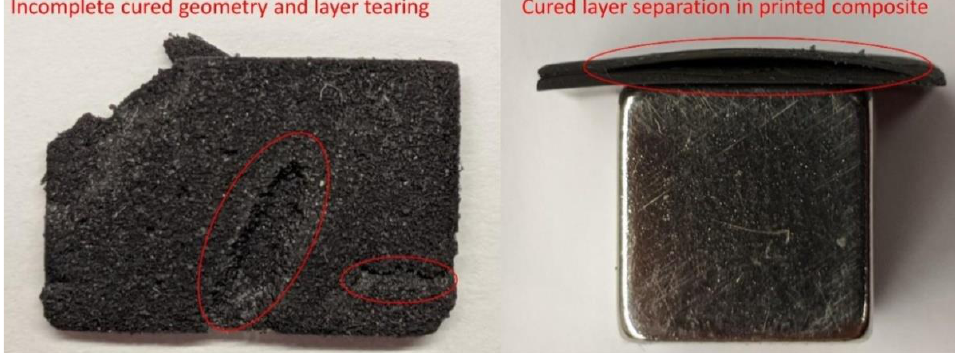
Figure 5. Defects in SrFeO ( left ) and NdFeB composite ( right ) printed with resins containing 25 wt% magnetic fillers. Reprinted from [52], copyright (2020), with permission from Elsevier.